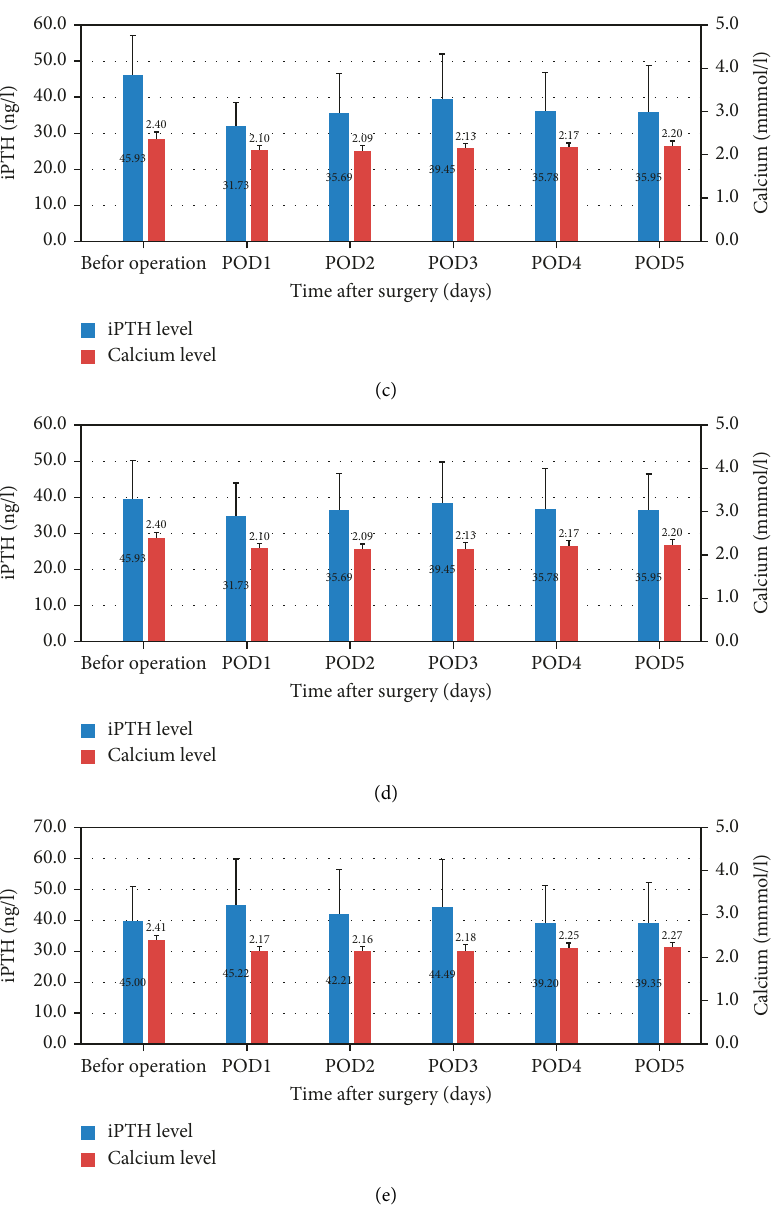
Figure 3: Mean serum levels of intact parathyroid hormone (iPTH) and calcium during the perioperative period in different parathyroid glands preserved in situ with excellent vascularity (PGPIEV) groups. (a), PGPIEV group 0; (b), PGPIEV group 1; (c), PGPIEV group 2; (d), PGPIEV group 3; (e), PGPIEV group 4. POD, postoperative day. Table 2: Fine-needle pricking test classification of parathyroid glands in patients who underwent total thyroidectomy plus central neck dissection.